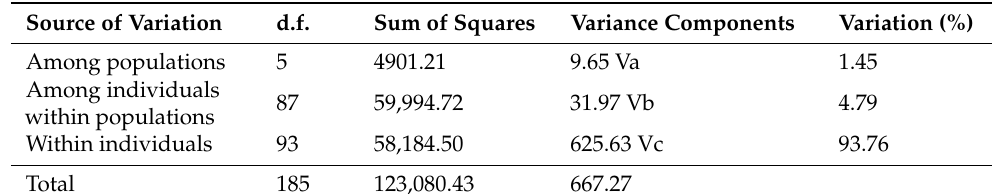
Table 2. Variations within, between and among the populations of Rhanterium eppaposum as observed by analysis of molecular variance